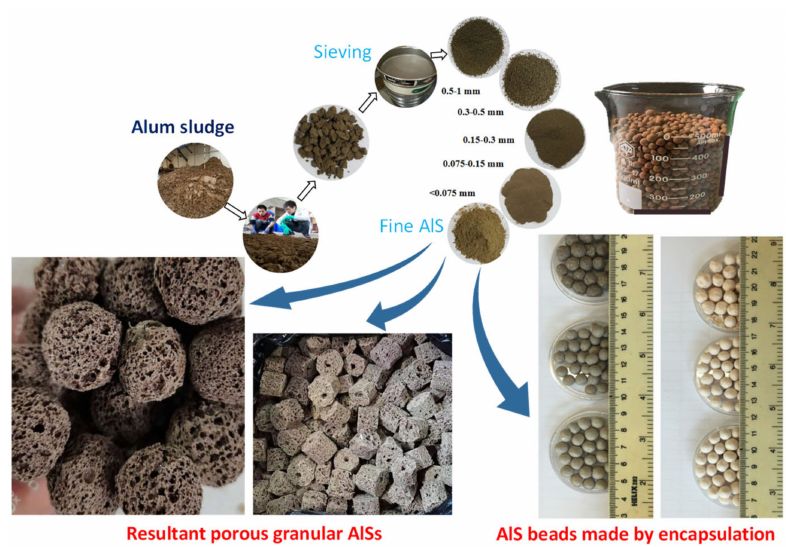
Figure 6. The resultant AlS granulation via encapsulation and